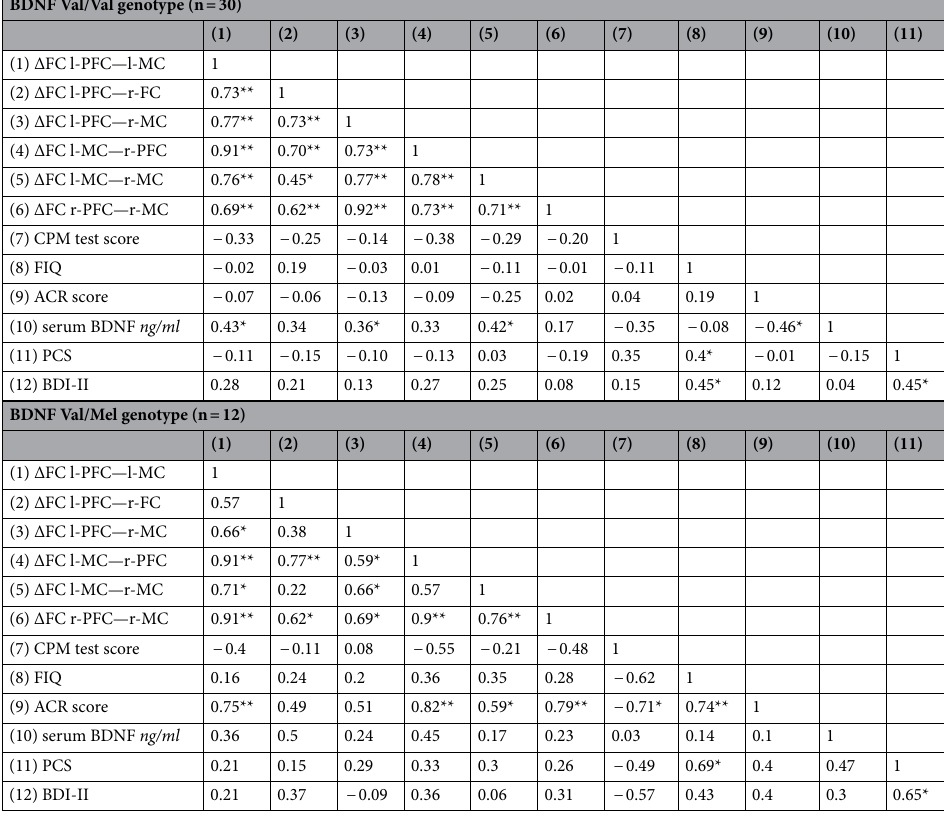
Table 3. Correlation among the ∆FC between regions of interest before and after a cold pressor test and potential confounding factors according to the BDNF genotypes (n = 42). BDNF brain-derived neurotrophic factor . Val/Val Val66Val homozygous . Val/Met Val66Met heterozygous . ΔFC difference in functional connectivity . l- left . r- right . PFC prefrontal cortex . MC motor cortex . CPM conditioned pain modulation . FIQ Fibromyalgia Impact Questionnaire ; ACR score American College of Rheumatology score for fibromyalgia diagnosis . PCS Pain Catastrophizing Scale . BDI-II Beck Depression Inventory II. *p < 0.05. **p <